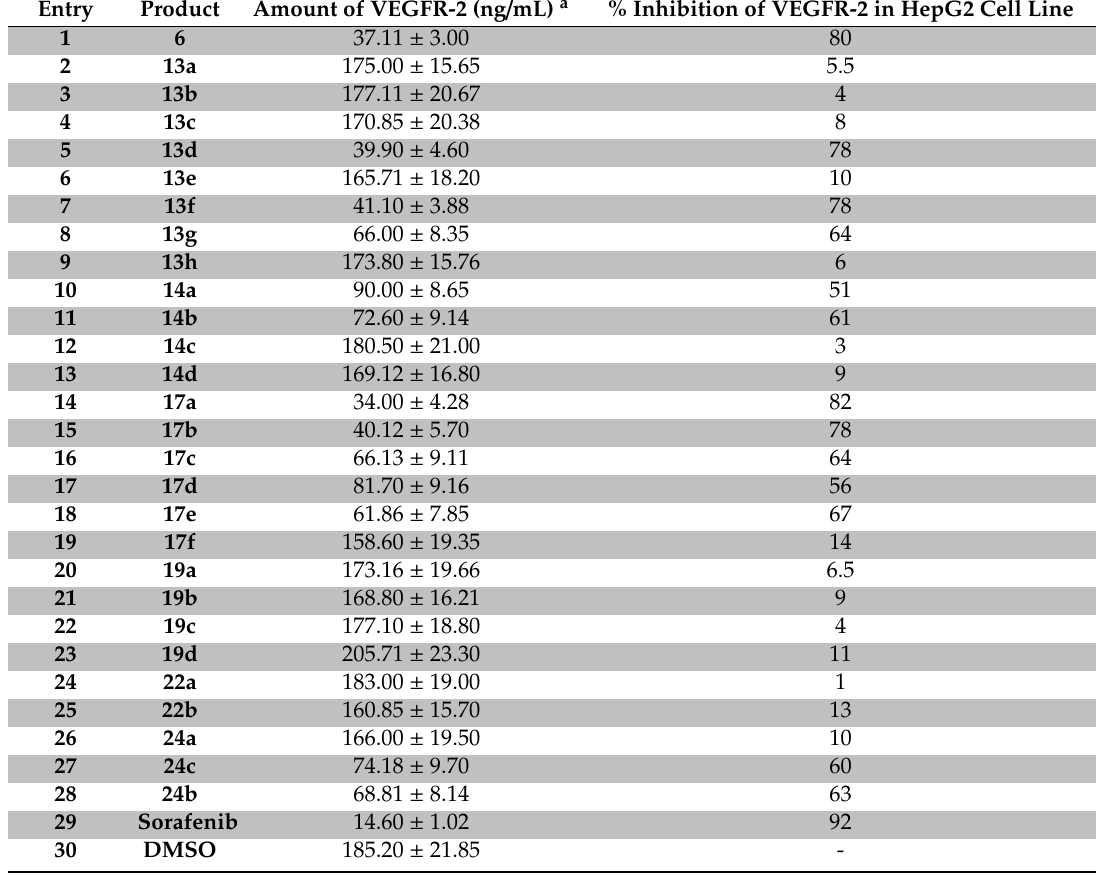
Table 4. Results of the e ff ects of the synthesized benzimidazoles on VEGFR-2 inhibitory activity in the HepG2 cell